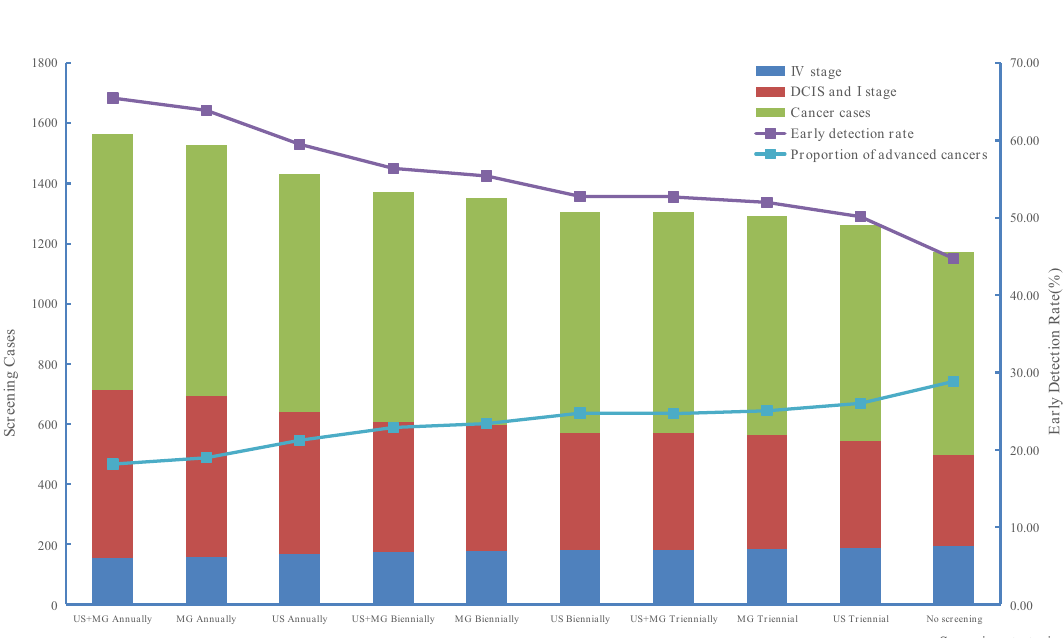
Figure 4. The morbidity and mortality for breast cancer at the end of the 45 years. US + MG combined ultrasound and mammography screening, MG mammography screening, US ultrasound